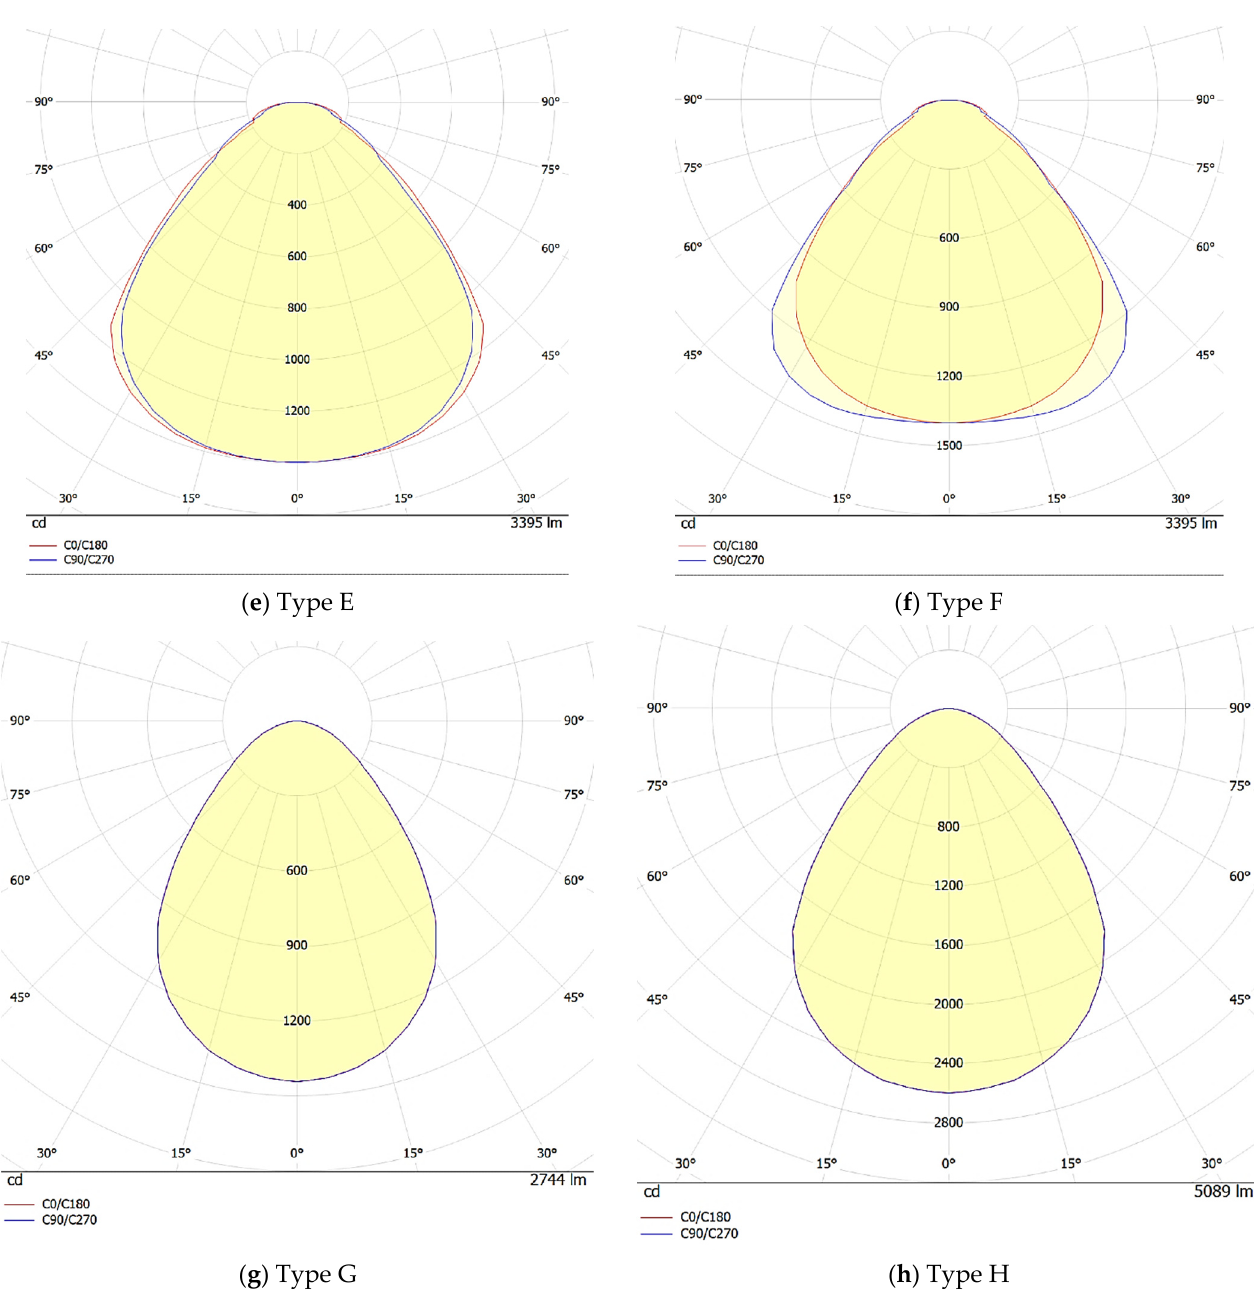
Figure 6. ( a – h ) (Luminaires types A–H) Luminous intensity distribution of the eight types of luminaires with diffusers studied in this research.